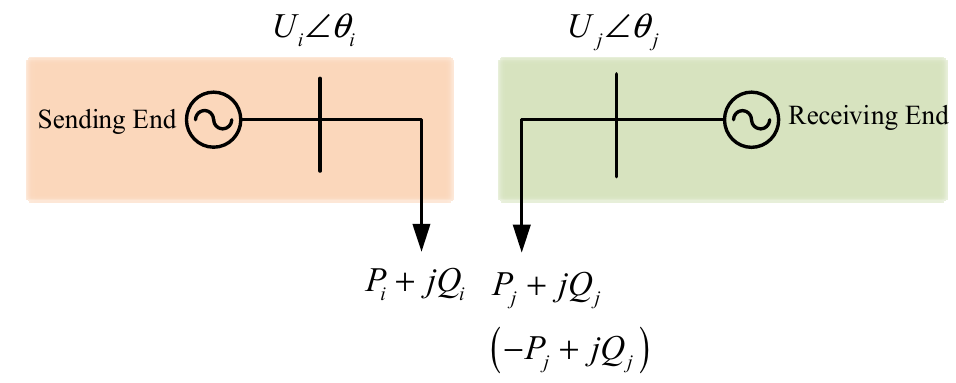
Figure 2. A simplified HVDC system model.